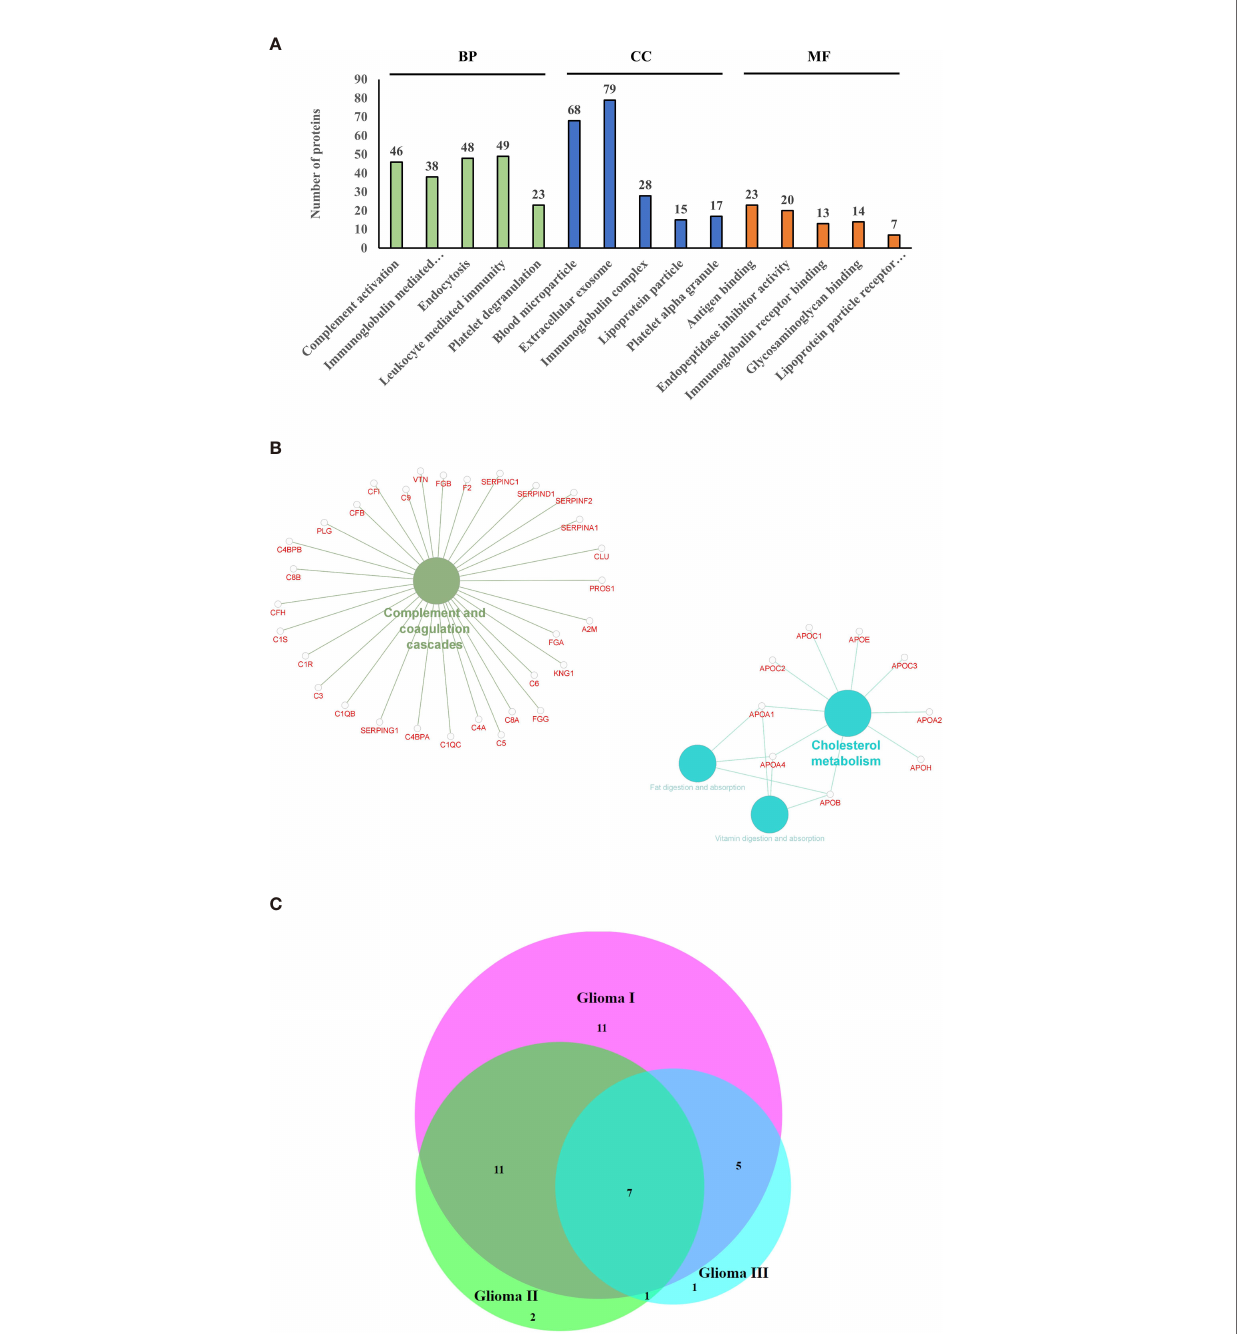
FIGURE 3 | Gene ontology and pathway analysis. (A) Gene ontology terms that were found to be enriched after functional annotation of identi fi ed protein using g- pro fi ler and the number of proteins under each category (BP, Biological Process; CC, Cellular Component; MF, Molecular Function). (B) Pathways that were found to be enriched among the identi fi ed proteins. (C) Venn diagram indicating the common differentially expressed proteins between the